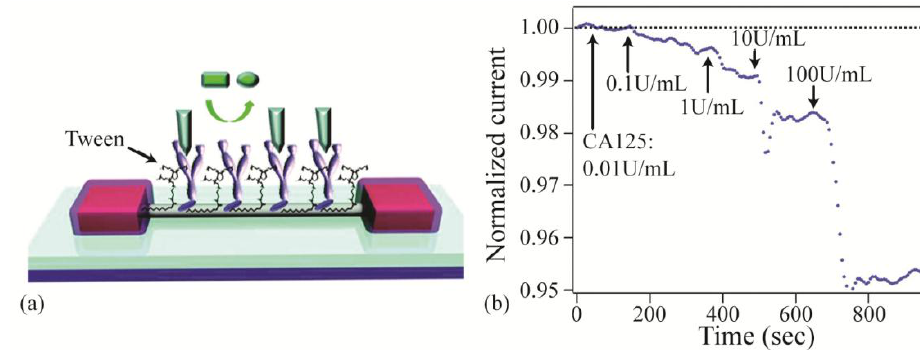
Figure 9. ( a ) Schematic of nanowire sensing platform, showing the Tween20 passivation layer which reduces nonspecific binding; ( b ) Normalized current versus time during cancer antigen 125 detection. When an antigen binds, the current decreases. The detection limit of 0.1 U/mL corresponds to 10 U/mL in the original serum, well below the 100–275 U/mL clinical levels used for cancer diagnosis. Adapted with permission from reference [24] ( c ) 2010 American Chemical